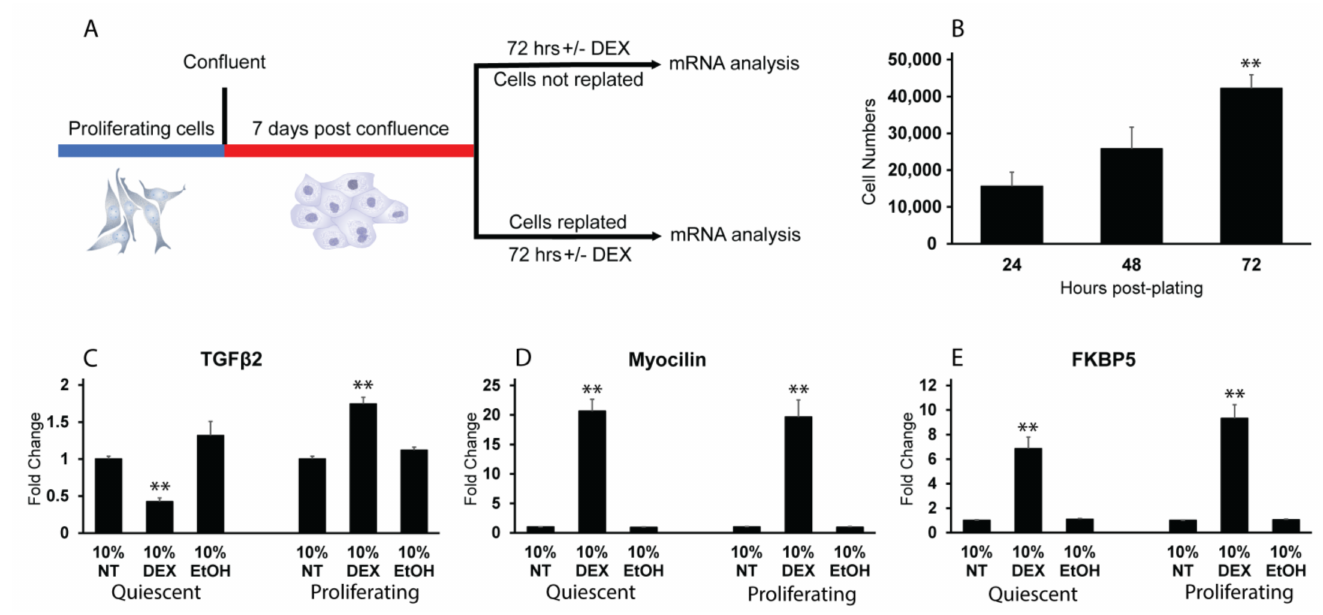
Figure 6. Re-entry into the cell cycle promotes DEX-induced TGF β 2 mRNA expression. ( A ). Schematic showing timeline of experiment. ( B ). Proliferative capacity of post confluent cells was verified by cell counts at 24, 48 and 72 h post replating. The 72 h time point was significantly greater than the 24 h time point, ** p < 0.01. ( C – E ). Comparison of mRNA levels for TGF β 2, myocilin and FKBP5 in 7-day post confluent cultures of quiescent HTM cells and quiescent HTM cells replated at a subconfluent density to induce re-entry into the cell cycle (proliferating). Cells were left untreated or were treated with DEX or EtOH for 72 h in the presence of 10% FBS. Quiescent cells that were forced back into the cell cycle by replating at a subconfluent density responded to DEX by increasing TGF β 2 mRNA levels in contrast to post confluent cultures that were left intact. Both groups of cells increased myocilin and FKPB5 mRNA levels in response to DEX treatment. ** p < 0.01, n = 2 biological replicates were conducted in